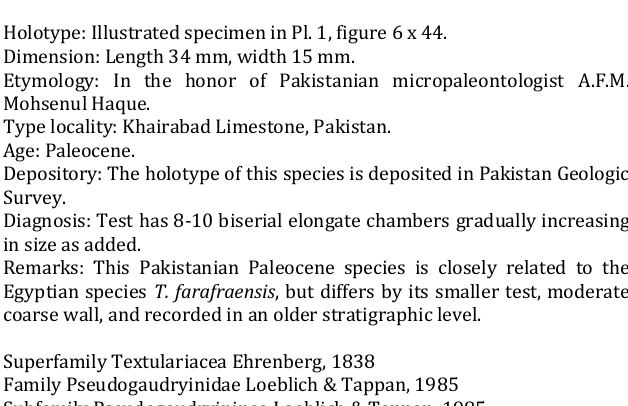
Figure 1a: Siphogaudryina africana (LeRoy, 1953) side view, 1b: S. africana (LeRoy, 1953) apertural view; 2. Siphogaudryina tellburmaensis